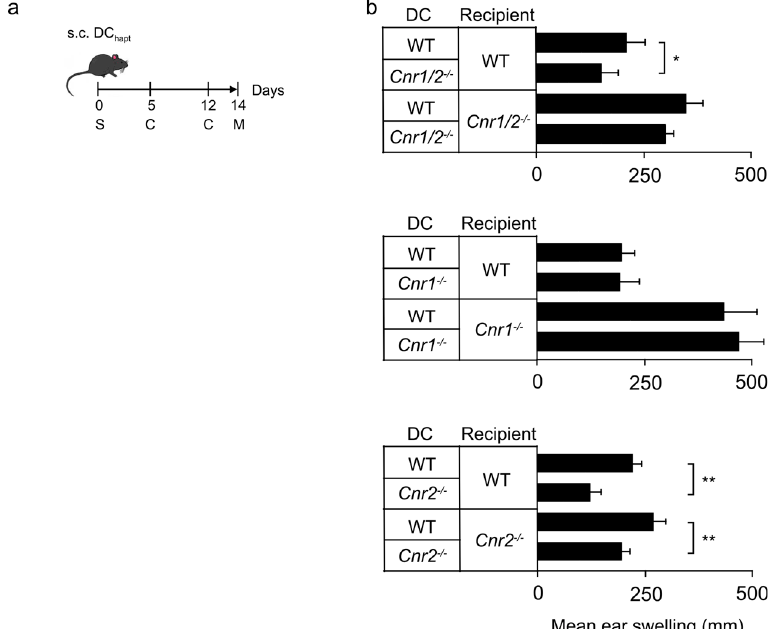
Figure 1. Reduced hapten-induced contact hypersensitivity upon transfer of cannabinoid receptor 2 (CB2)-deficient dendritic cells (DCs) into recipient mice. ( a ) Mice were sensitized (S) by subcutaneous (s.c.) injection of haptenized DCs and challenged (C) with 2,4-dinitro-1-fluorobenzene (DNFB). Ear swelling (M) was measured 48 h after the second challenge. ( b ) Mean ear swelling 48 h after the second challenge with DNFB (± SEM, n = 5 mice/group) in wild type (WT), Cnr1/2 − / − , Cnr1 − / − and Cnr2 − / − mice sensitized with WT DCs, Cnr1 − / − /Cnr2 − / − DCs (top), Cnr1 − / − DCs (middle) and Cnr2 − / − DCs (bottom). Experiments were repeated two times with similar results. * p < 0.05, ** p < 0.01.